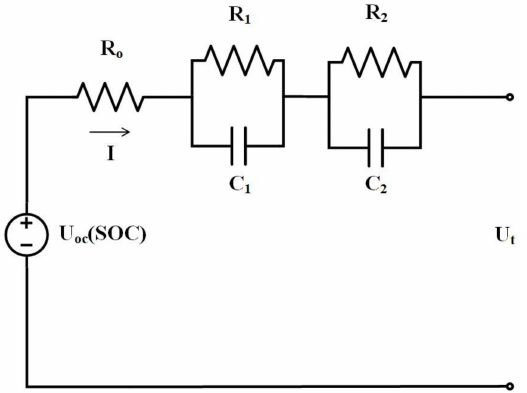
Figure 14. Dual polarisation model [34–39].